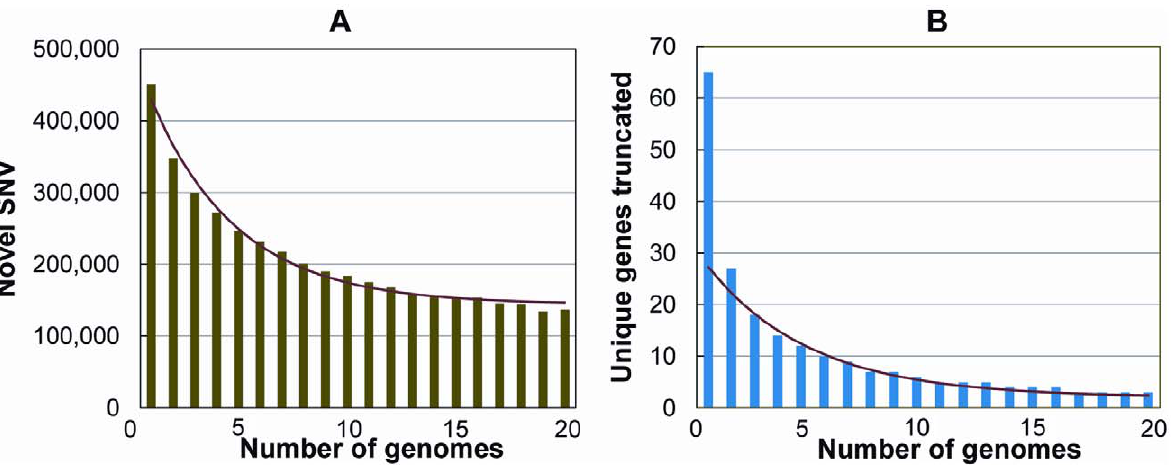
Figure 5. Number of novel SNVs and novel knocked-out genes as the number of genomes increases. The total number of novel variants, and the total number of novel genes containing protein truncating or stop loss variants, continues to drop as additional genomes are added to the analysis. Shown are the number of unique SNVs (A) and unique genes carrying a homozygous protein-truncating or stop loss variant (B) per genome, as a function of the number of genomes already considered. The genomes were added in a random order to both analyses, and 1000 permutations were performed and averaged.